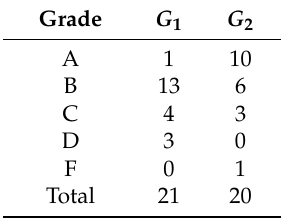
Table 1. Student